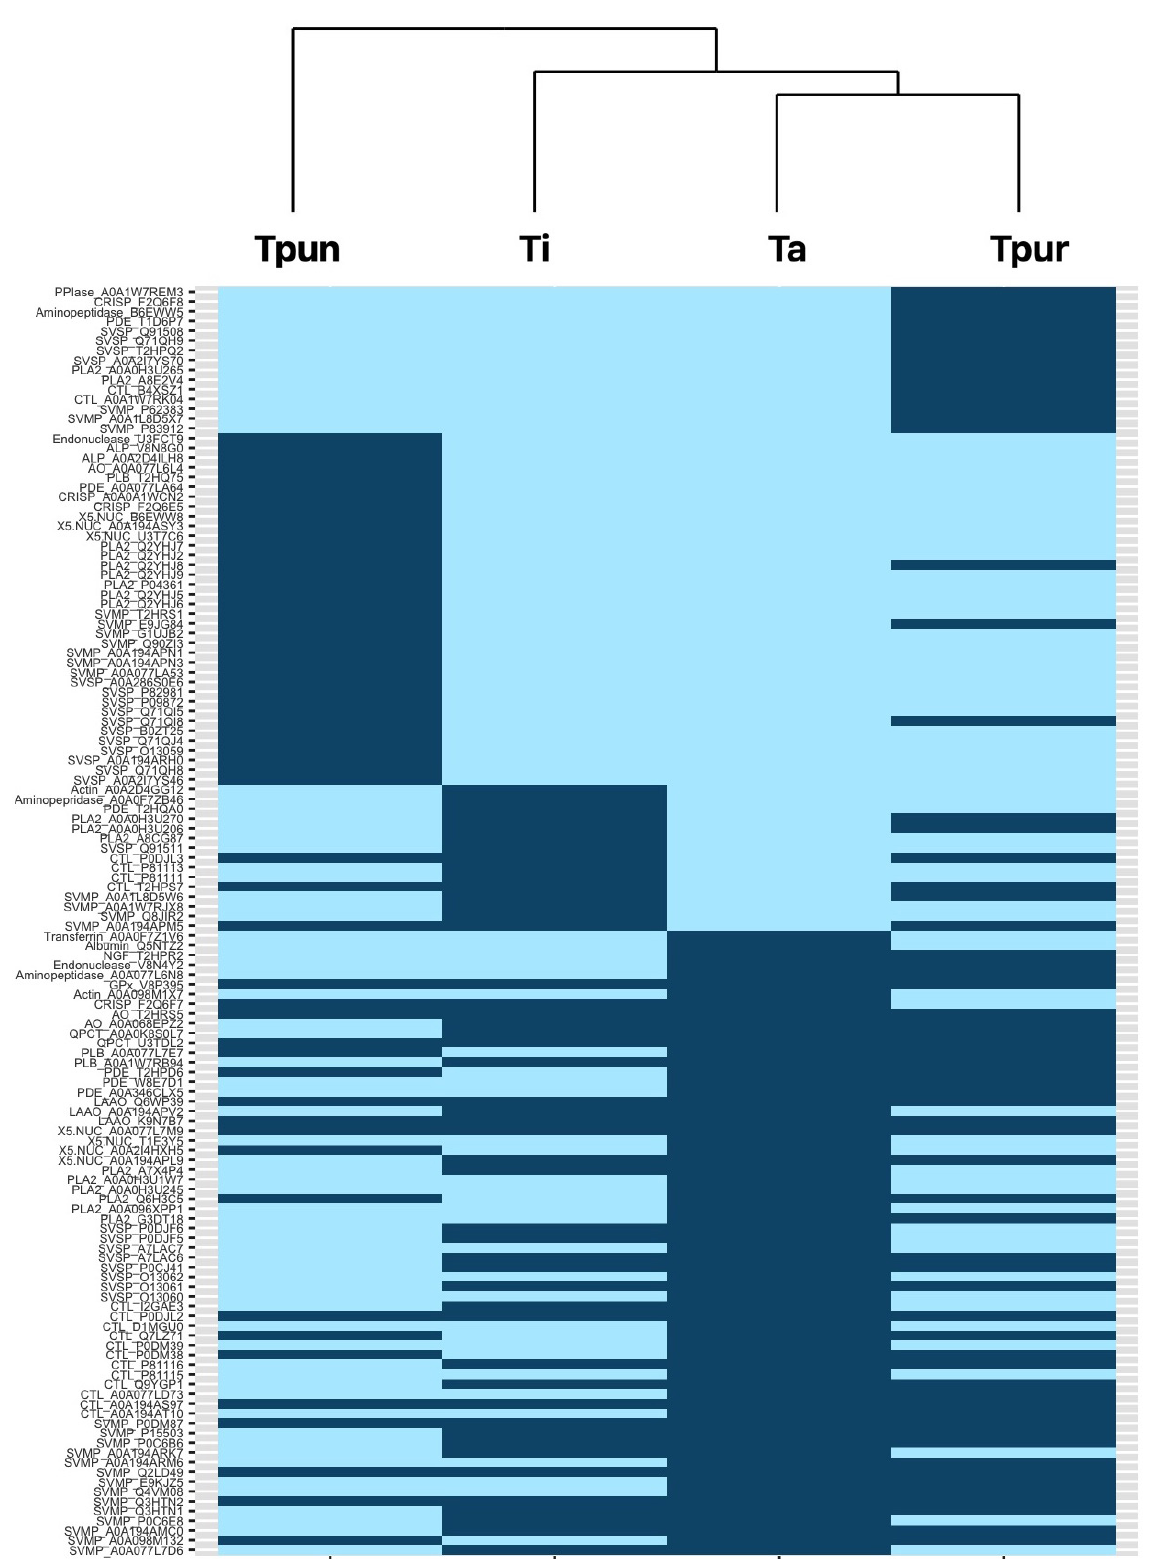
Figure 6. Clustering of T. albolabris (Ta), T. insularis (Ti), T. purpureomaculatus (Tpur), and T. puniceus (Tpun) venoms based on their proteomes. Proteins represented by protein family followed by the accession code. For each venom, a given protein is either present (pale blue) or absent (dark blue). SVMP, snake venom metalloproteinase; SVSP, snake venom serine protease; PLA2, phospholipase A2; CTL, snake C-type lectin; CRiSP, cysteine-rich protein; LAAO, L-amino acid oxidase; PDE, phosphodiesterase; NUC, 5’-nucleotidase; endonuclease, endonuclease domain-containing 1 protein; PLB, phospholipase B; AO, amine oxidase; QPCT, glutaminyl-peptide cyclotransferase; NGF, nerve growth